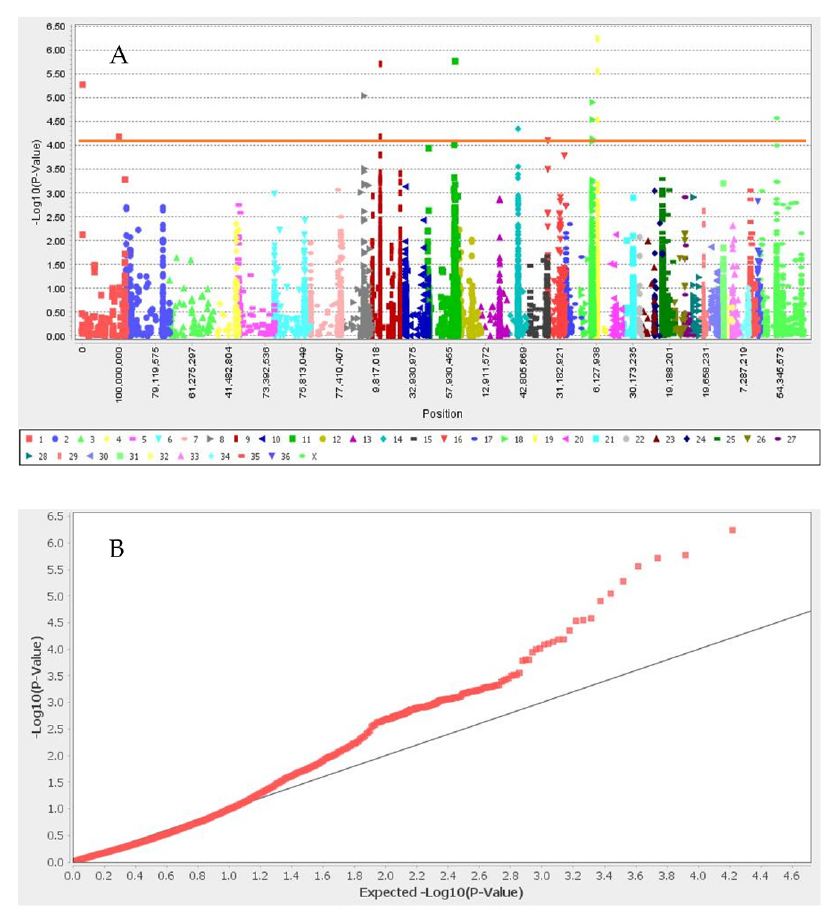
Figure 3. Manhattan plot ( A ) and q–q plot ( B ) of coat color for black color. Red line in Manhattan plot is Bonferroni threshold. The chromosomal position of each SNP was displayed in different colors in Manhattan plot. Red and gray line in the q–q plots represent the − log p -value of the entire study and expected value,